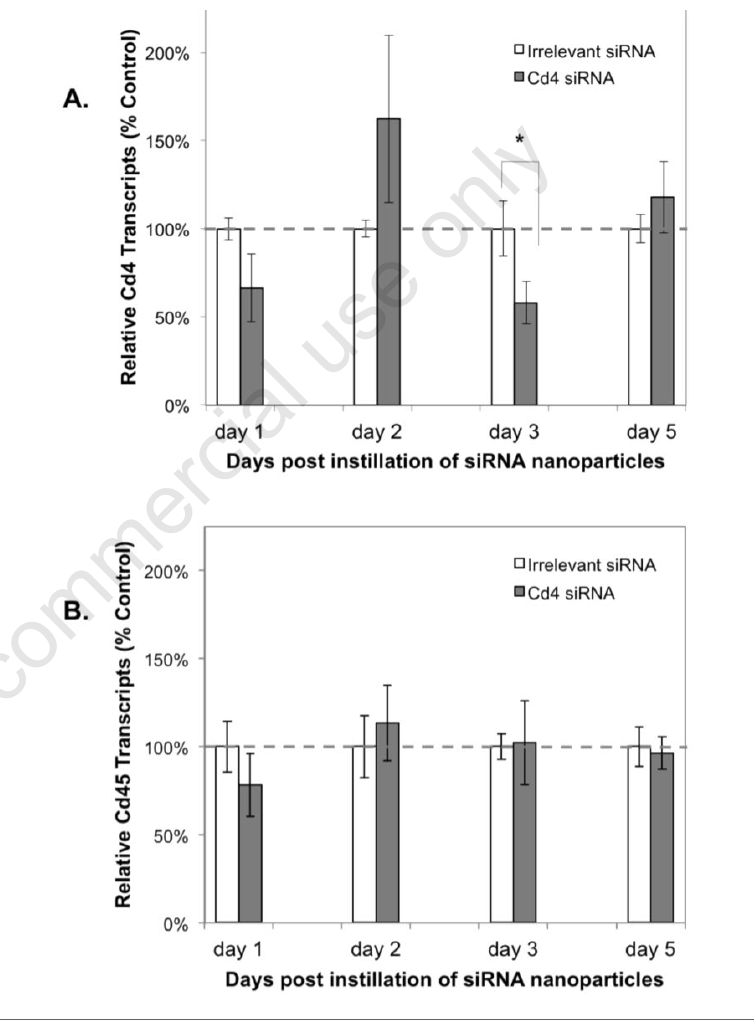
Figure 5. Nanoparticles containing siRNA to murine Cd4 reduce Cd4 expression but not Cd45 expression in murine uterine tissues. Nanoparticles containing siRNA to an irrel- evant sequence or to murine Cd4 (10 µg/mouse) were instilled directly into each uterine horn. On days 1, 2, 3 and 5, the mice were euthanized and uterine tissues assessed by real-time PCR for Cd4 expression (Panel A) or for Cd45 expression (Panel B) in tripli- cate and normalized to murine β -actin expression. Average relative expression of Cd4 or Cd45 was compared between groups of mice treated with the irrelevant siRNA control (white bars) or Cd4-specific siRNA (grey bars). Two mice are represented in each group for days one and two and four mice are represented in each group for days 3 and 5. Error bars show the standard deviation of the means among the mice in each group. A statisti- cally significant difference (as denoted by a single asterisk) between the irrelevant and Cd4-specific siRNA treated groups was observed on day 3 (P<0.05). Bars with no aster- isk did not reach statistical significance at the 95% confidence